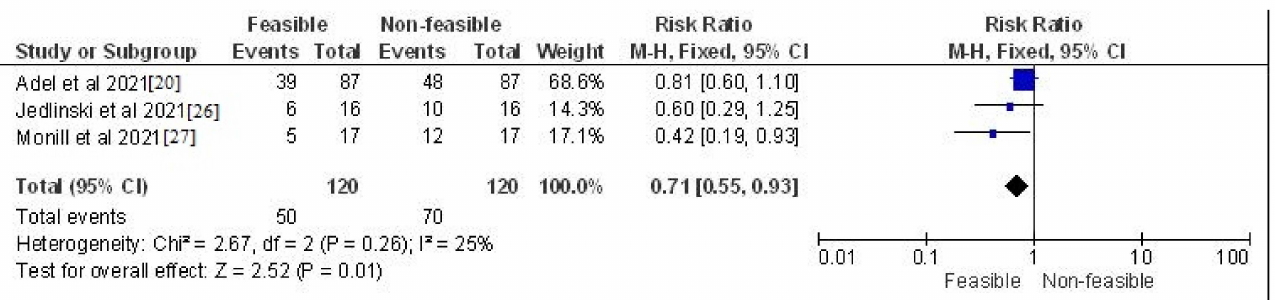
Figure 4. Odds ratio of systematic reviews which assessed the feasibility vs. non-feasibility rates of their respective trends represented on a forest plot after meta-analysis [20,26,27].